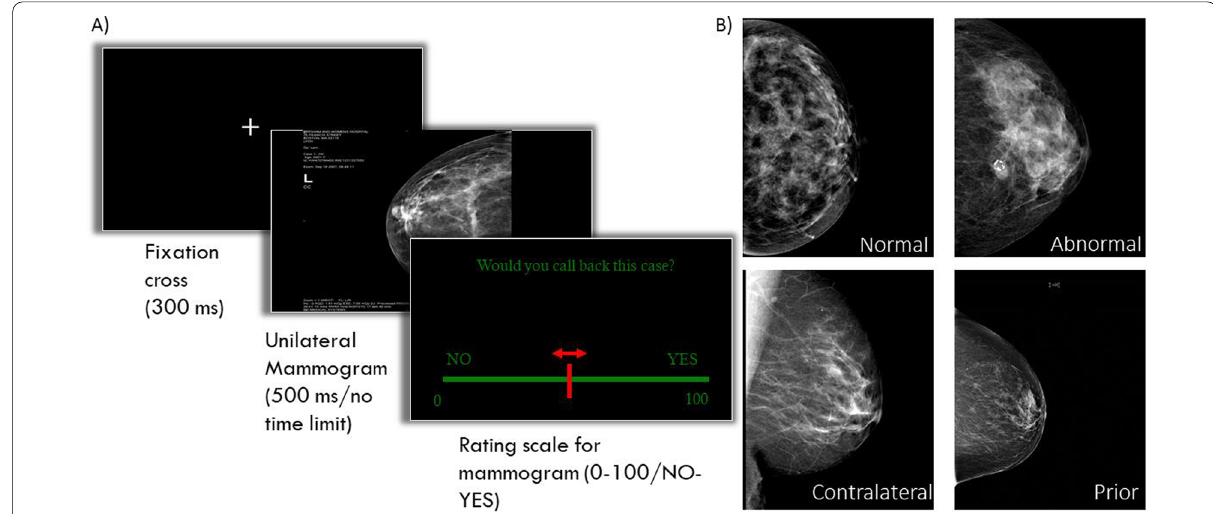
Fig. 1 Simplified overview of the experimental procedure ( A ) and example mammograms for each of the four types used in this experiment ( B